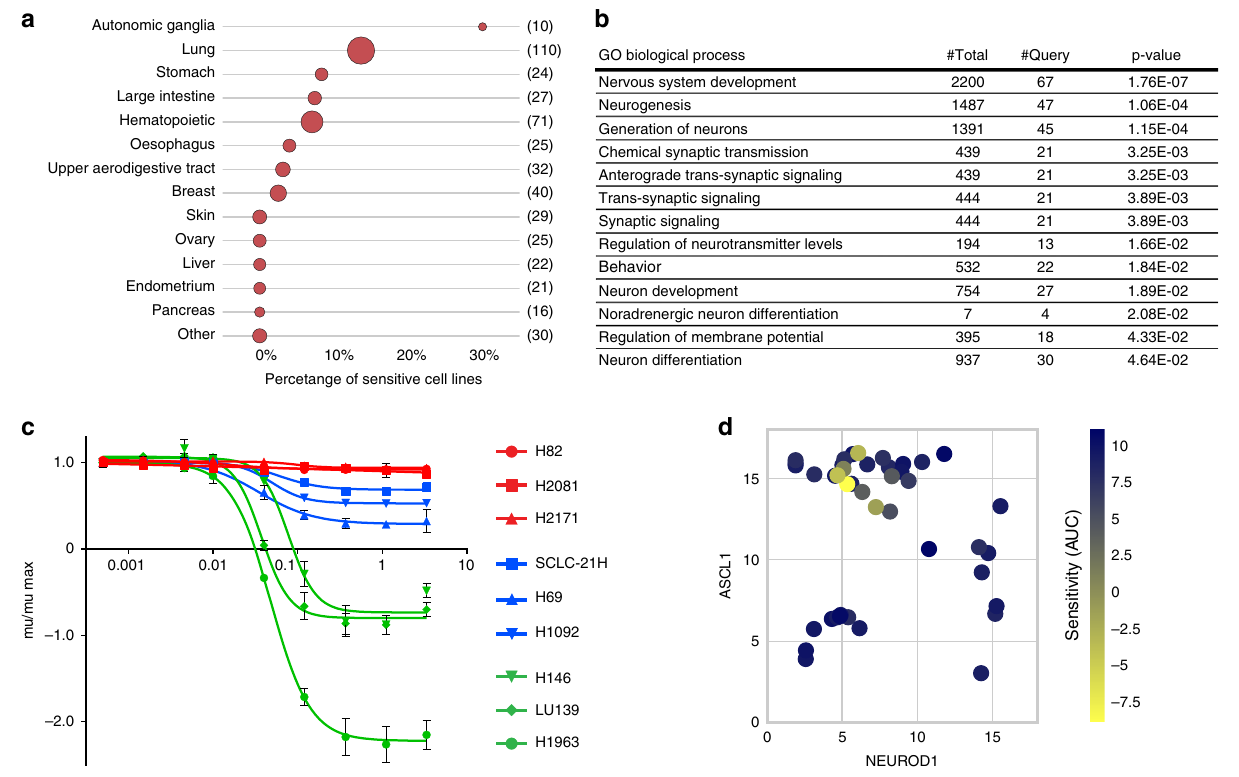
Fig. 1 A subset of SCLC cancer cell lines is sensitive to NB-598. a Summary of NB-598 sensitivities observed in a panel of 482 cancer cell lines. Number in parentheses represents the total number of cell lines within a particular category and the size of the circle is proportional to the number of sensitive cell lines within each category. Cells were de fi ned as sensitive based on GI75 < 2 μ M. b Gene ontology enrichment of gene expression in cell lines sensitive to NB-598. Gene expression data from the CCLE database was obtained for 451 cell lines and genes differentially expressed in cells sensitive to NB-598 ( t test, p < 0.001) were analyzed for statistically overrepresented GO categories. GO categories were restricted to those with <3000 genes. c NB-598 sensitivity in a representative panel of SCLC cell lines. Cell lines were categorized based on the measured AUC of mu/mu.max curve and were de fi ned as sensitive (AUC < 2), moderate (2 < AUC < 9), and insensitive (AUC > 9). Classi fi cation categories are shown in green, blue, and red colors, respectively. Mu/mu.max calculations were used to compare growth rates of drug-treated to DMSO-treated cells (mu.drug/mu.DMSO), where maximum growth is observed in DMSO-treated cells. Value of mu/mu.max = 1 corresponds to no effect of drug added. Values of mu/mu.max < 0 denote cytotoxic effects (fewer cells at Tend than T0). Values of mu/mu.max between 0 and 1 denote various extents of partial growth inhibition. Mean values of triplicate measurements from a representative experiment are plotted and error bars represent s.d. d Relative mRNA expression levels of ASCL1 and NEUROD1 as a function of NB-598 sensitivity. Expression levels are represented as log2-transformed normalized counts. AUC-based NB-598 sensitivity of individual SCLC cell lines is indicated on a blue-to-yellow